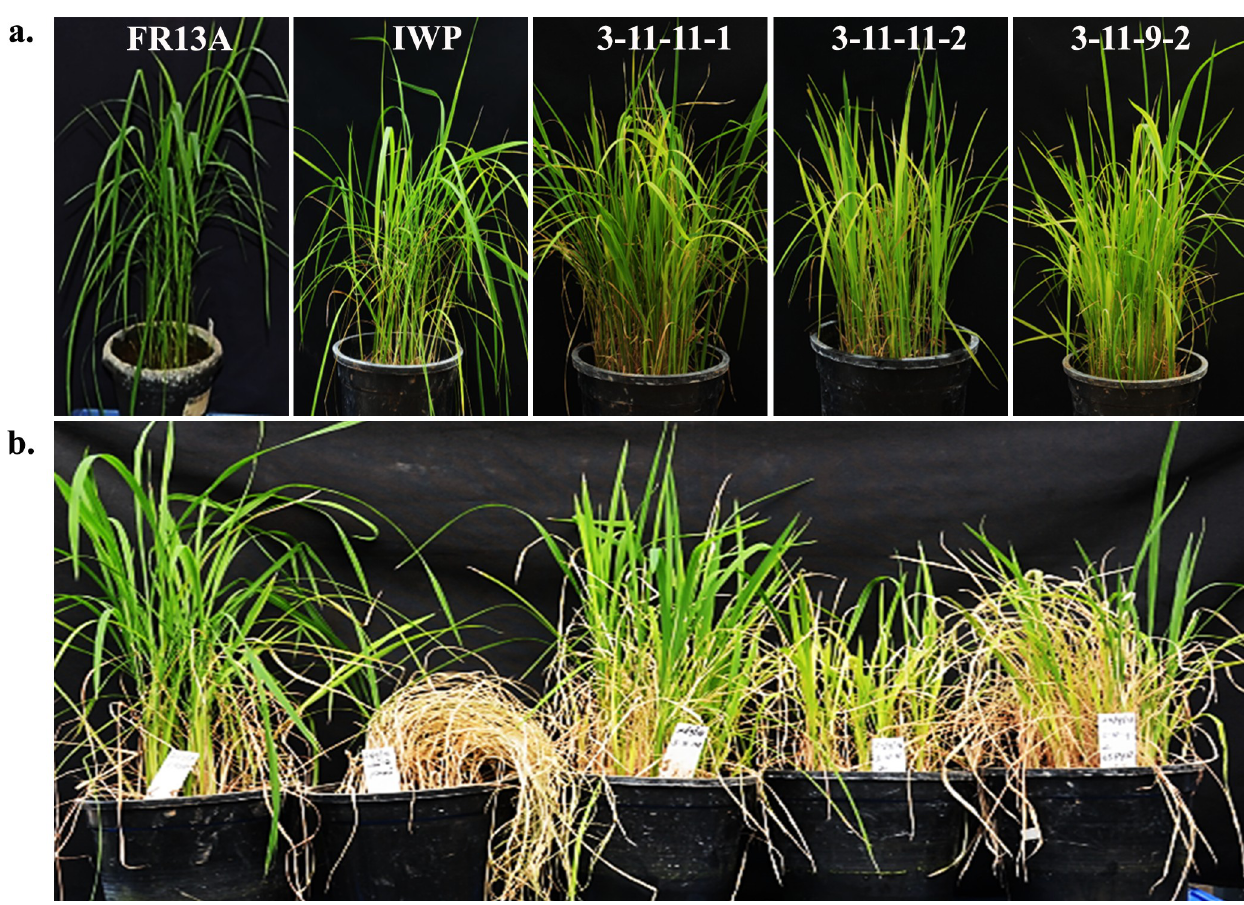
Fig 9. Responses of BILs and parents under control conditions (a) and 12 days after de-submergence (b).